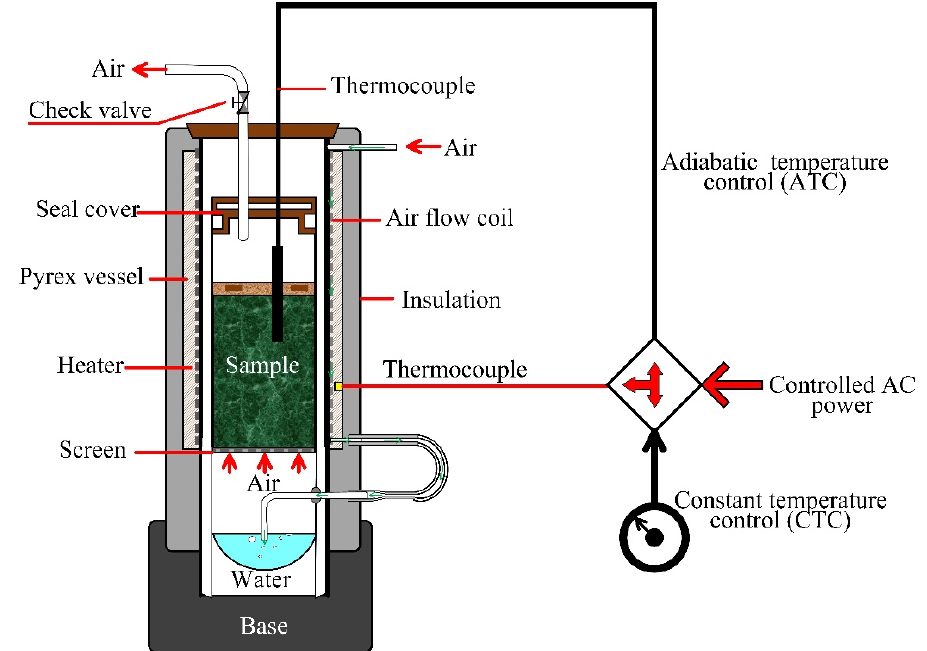
Figure 5. FR-2 test apparatus with control loop for adiabatic mode operation.